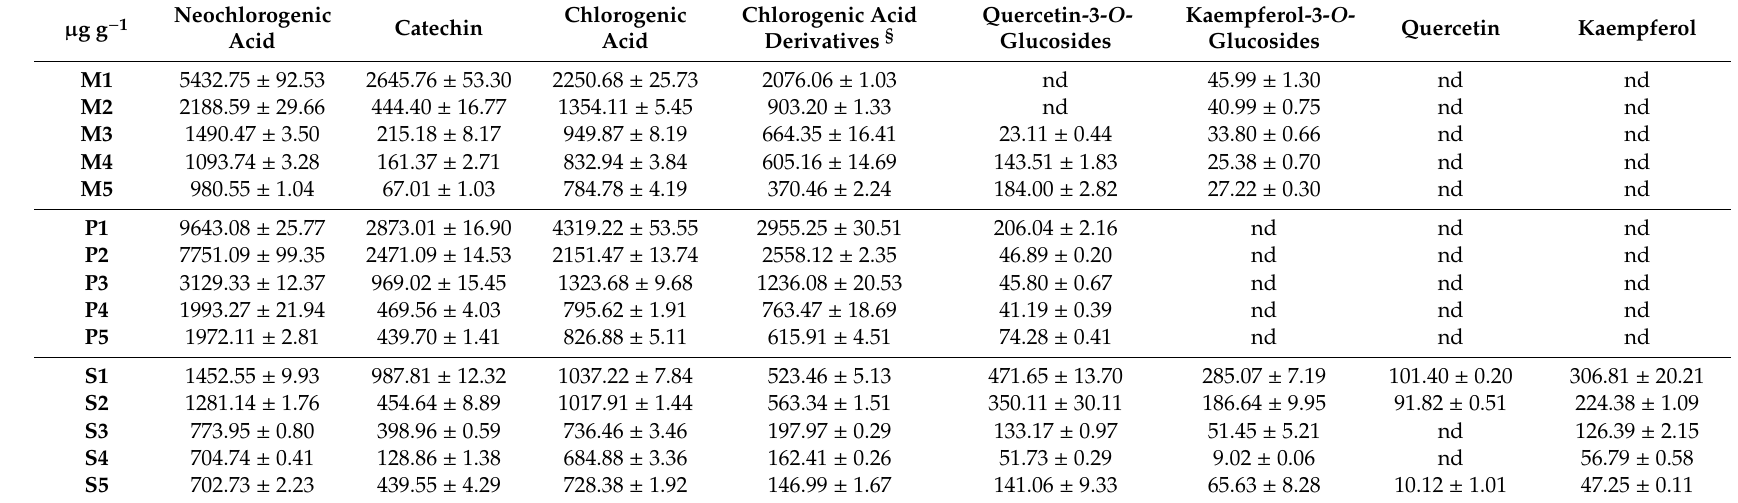
Table 3. Content of phenolic compounds ( µ g g − 1 DW; mean value ± standard error, n = 3) in the fruit flesh of the three species of plum* at di ff erent development